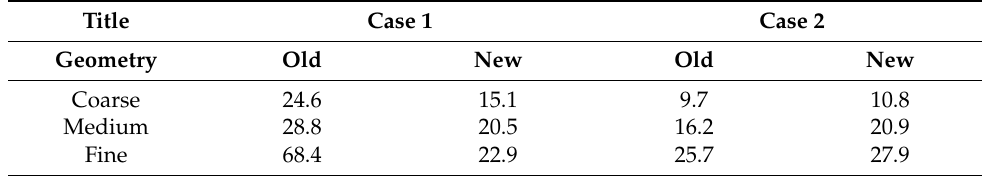
Table 2. Nodes (10 6 ) in meshes used for case 1 and 2 spiral case simulations.